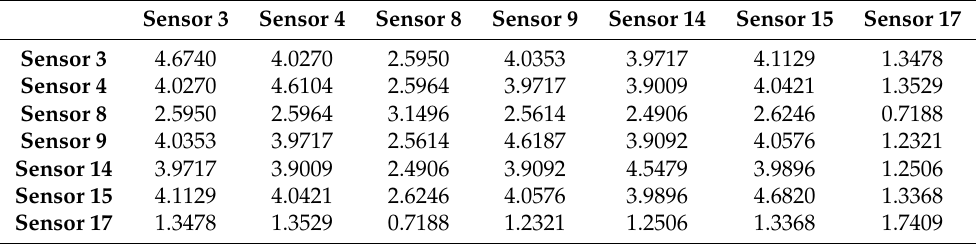
Table 4. Mutual information values among sensors selected by quantitative strategy for data set